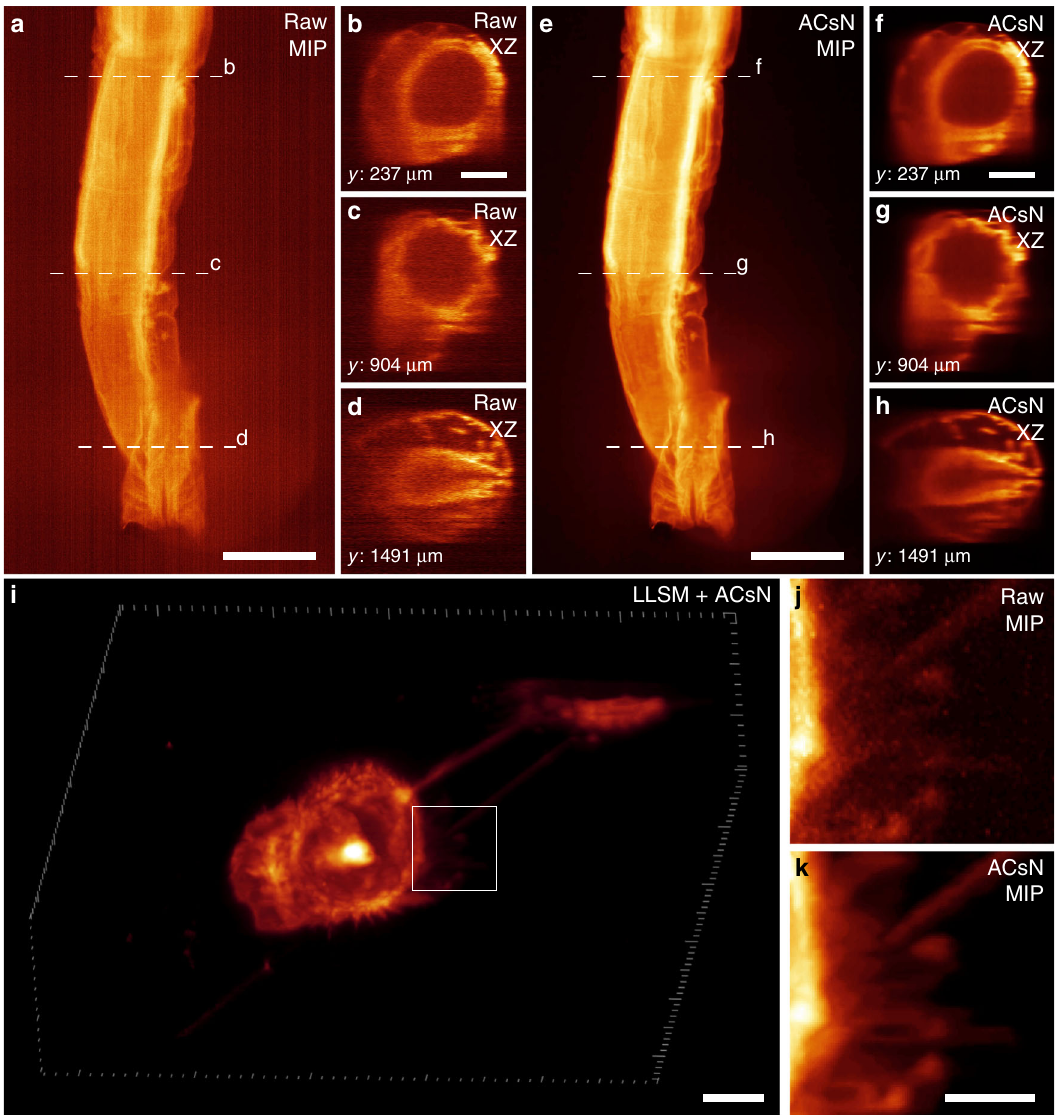
Fig. 6 ACsN processing of volumetric data obtained with SPIM and LLSM. Maximum intensity projections (MIP) of SPIM images of a fl uorescently labeled adult brine shrimp before ( a ) and after ( e ) ACsN denoising. Orthogonal views along the XZ plane of the raw ( b – d ) and denoised ( f – h ) volumetric scans at y = 237 mm ( b , f ), y = 904 mm ( c , g ), and y = 1491 mm ( d , h ). Slices along the XY and YZ plane have been provided in Supplementary Fig. 7. i Three-dimensional rendering of live human lung cancer cells (NCI-H1299 NSCLC) acquired with LLSM and processed with ACsN denoising. Zoomed-in images of the area corresponding to the white box in i before ( j ) and after ( k ) ACsN denoising. The corresponding time-lapse sequence has been provided in Supplementary Movies 6 and 7. MIP images and representative slices are depicted in Supplementary Figs. 9 and 10. Scale bars: 400 μ m ( a , e ), 100 μ m ( b , f ), 10 μ m ( i ), 4 μ m ( k